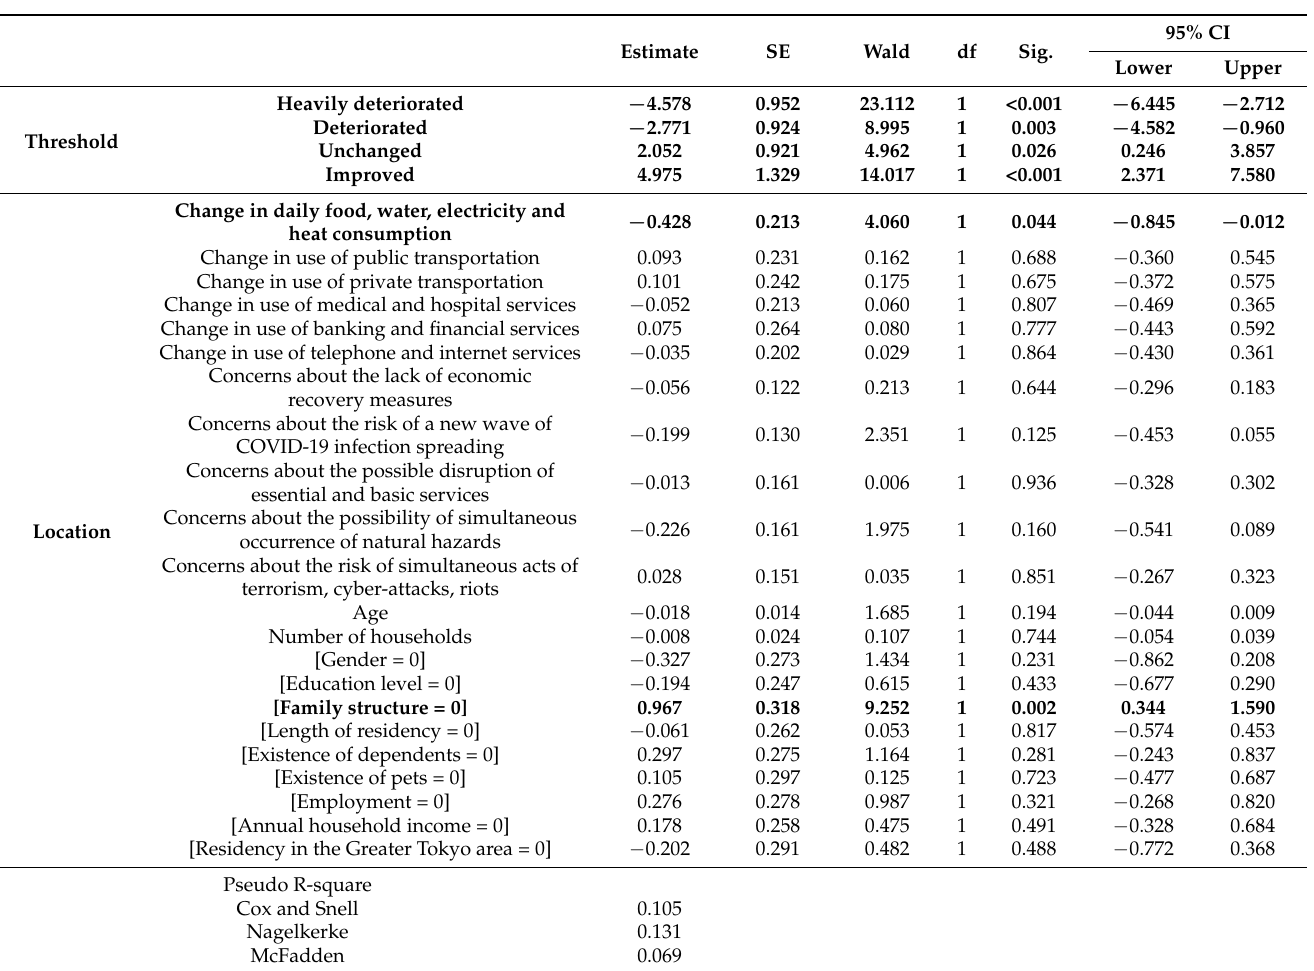
Table 2. Parameter estimates for change in job